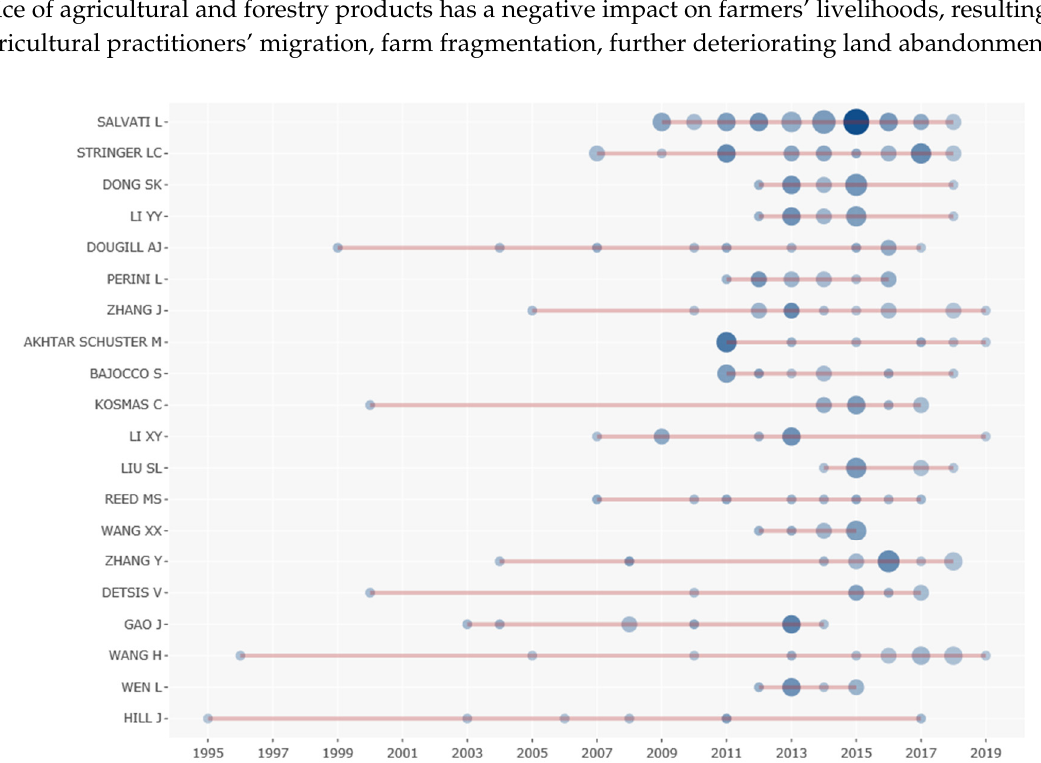
Table 3. Top 10 influential authors in the field of land degradation.